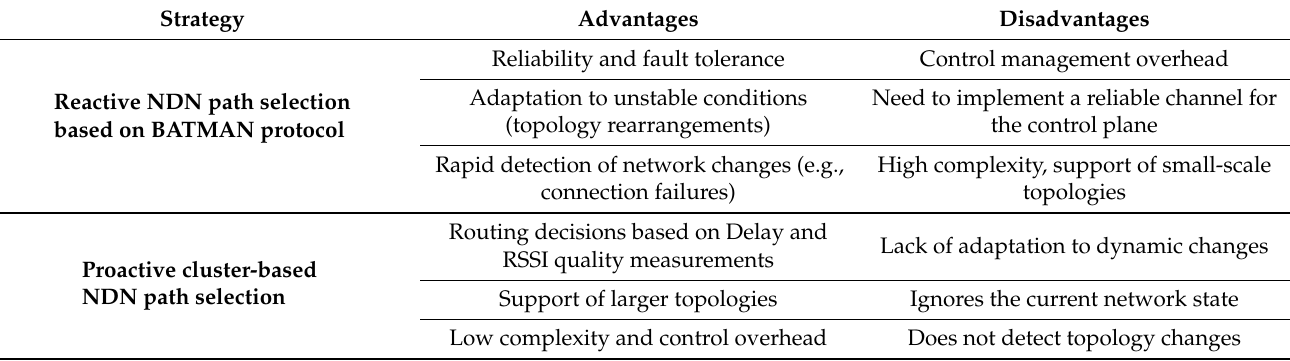
Table 11. Comparison of reactive and proactive NDN path selection